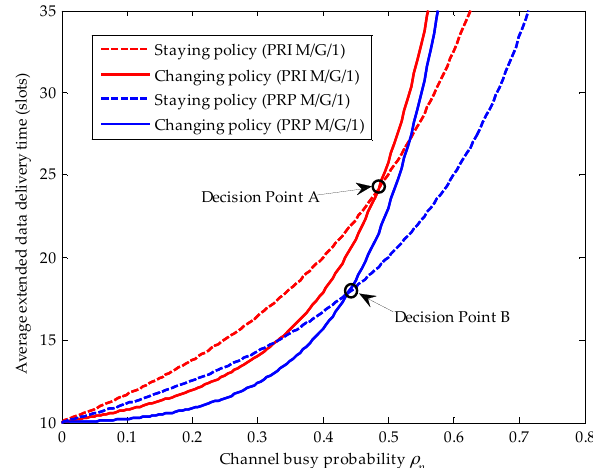
Figure 6. Compares the traffic-adaptive policy of the considered secondary user (SU) in the preemptive repeat identical (PRI) M/G/1 and the preemptive resume priority (PRP) M/G/1 queuing network models, where the primary connection follows the exponential distribution, λ s “ 0.01 (arrivals/slot), [ ] 10 E X s